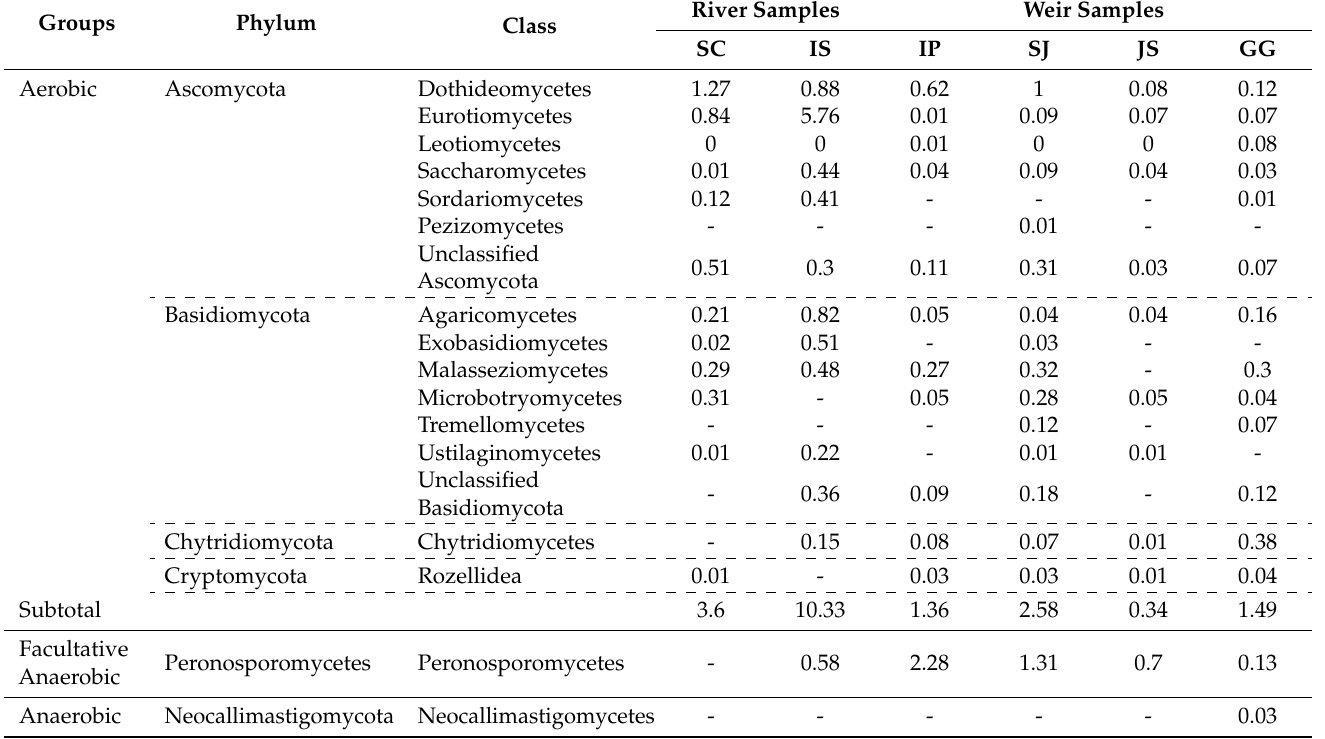
Table 3. The fungal component of the gut contents of the Polypedilum